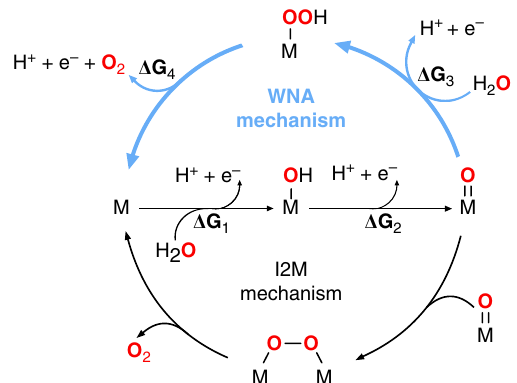
Fig. 1 Catalytic cycles for the two primary reaction pathways proposed for the